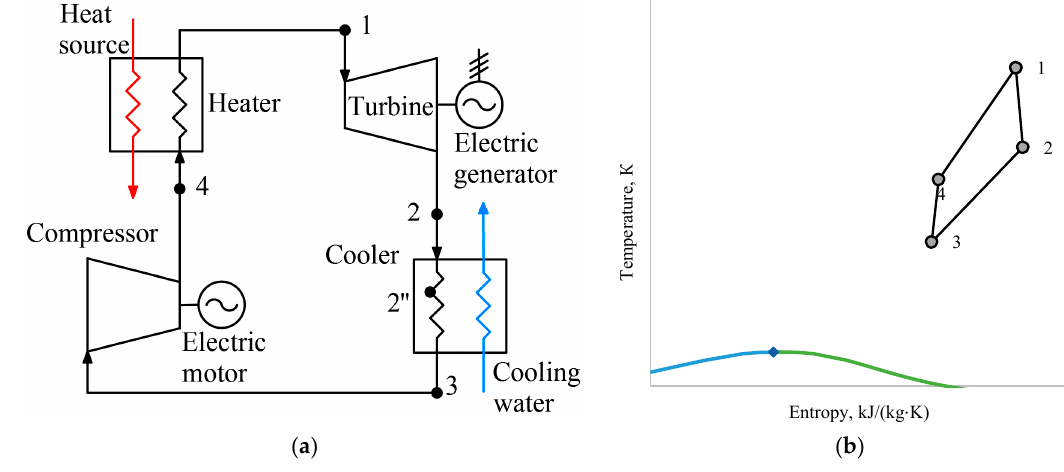
Figure 4. Brayton cycle: ( a ) Scheme; ( b ) Cycle.